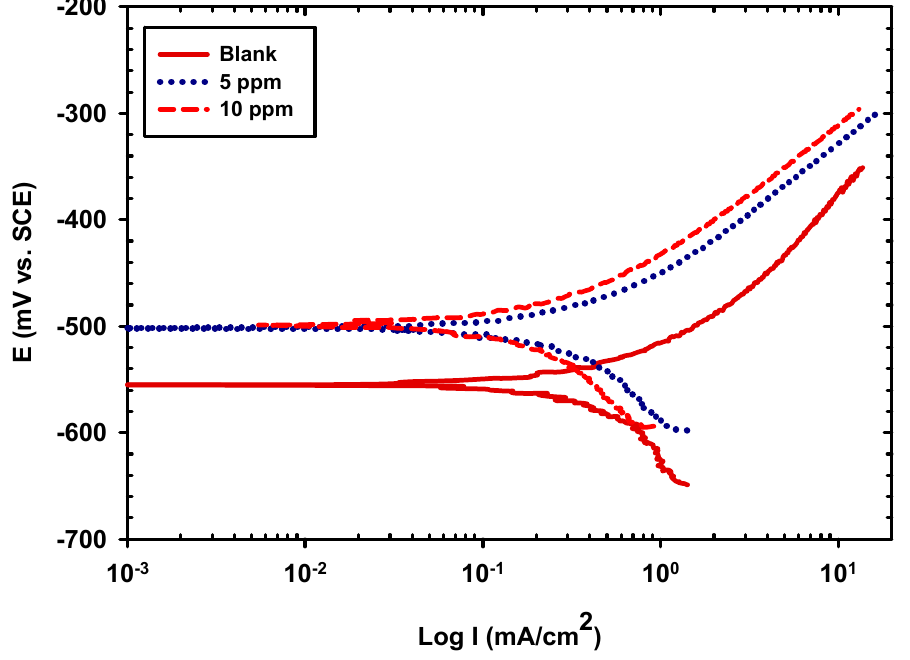
Figure 7. Potentiodynamic polarization curves for mild steel in 3.5% NaCl solutions without and with different concentrations of [EMIm]Cl.